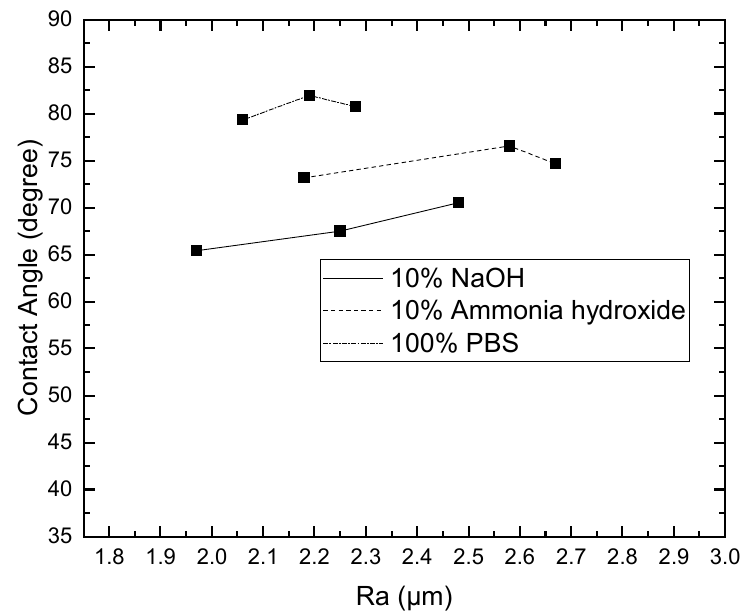
Figure 10. Contact angles of distilled water on Parylene C coated on a substrate with a Shore A hardness of 85 soaked in different solutions.